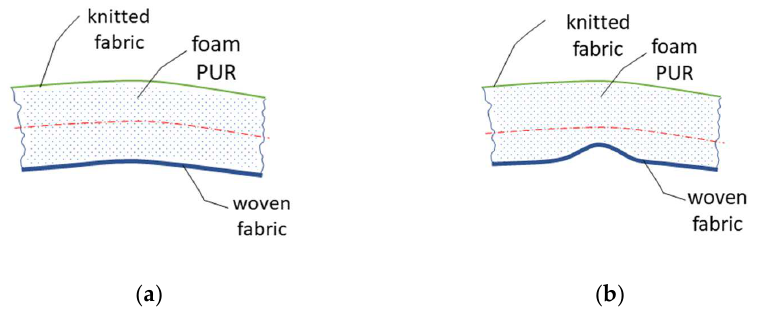
Figure 11. Bending properties of the laminate layer: ( a ) good quality textile; ( b ) textile with a defect.